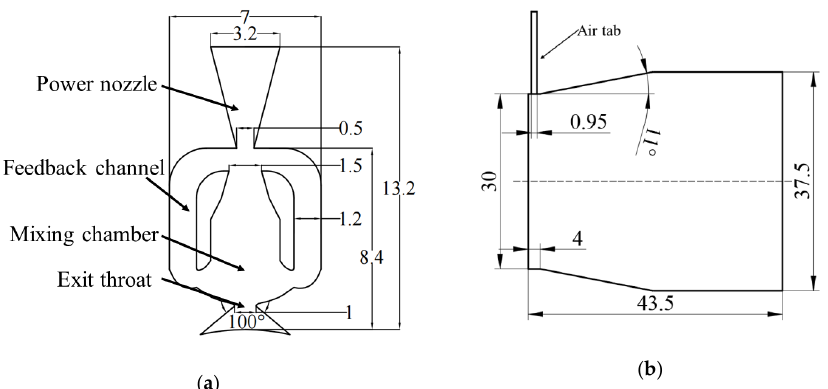
Figure 1. Schematic of fluidic exciters and convergent nozzle: ( a ) Fluidic oscillator; ( b ) Convergent nozzle and